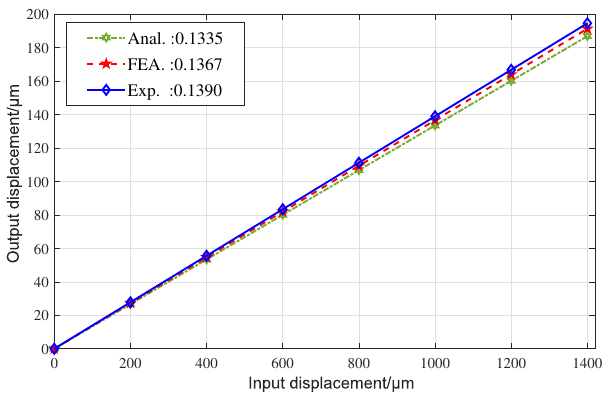
Figure 10. Comparison of displacement reduction ratio.